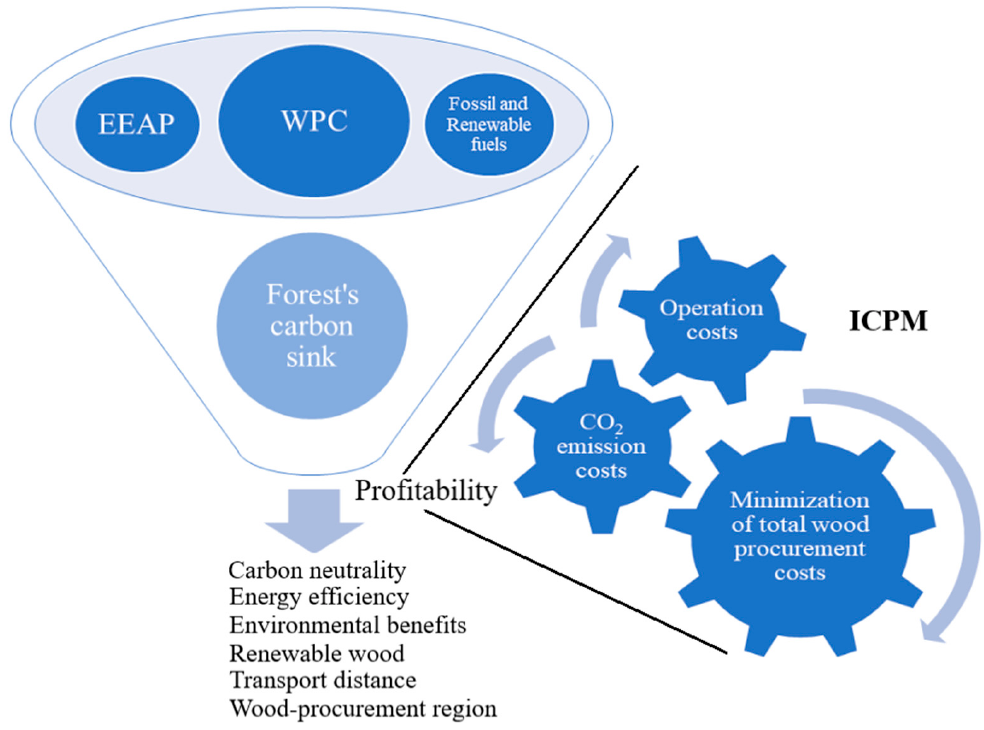
Figure 3. DDICPM of WPCs in wood procurement of IEMI. Directions of the arrows describe the e ff ects of synchronizing in the case of minimization of CO 2 emission costs.